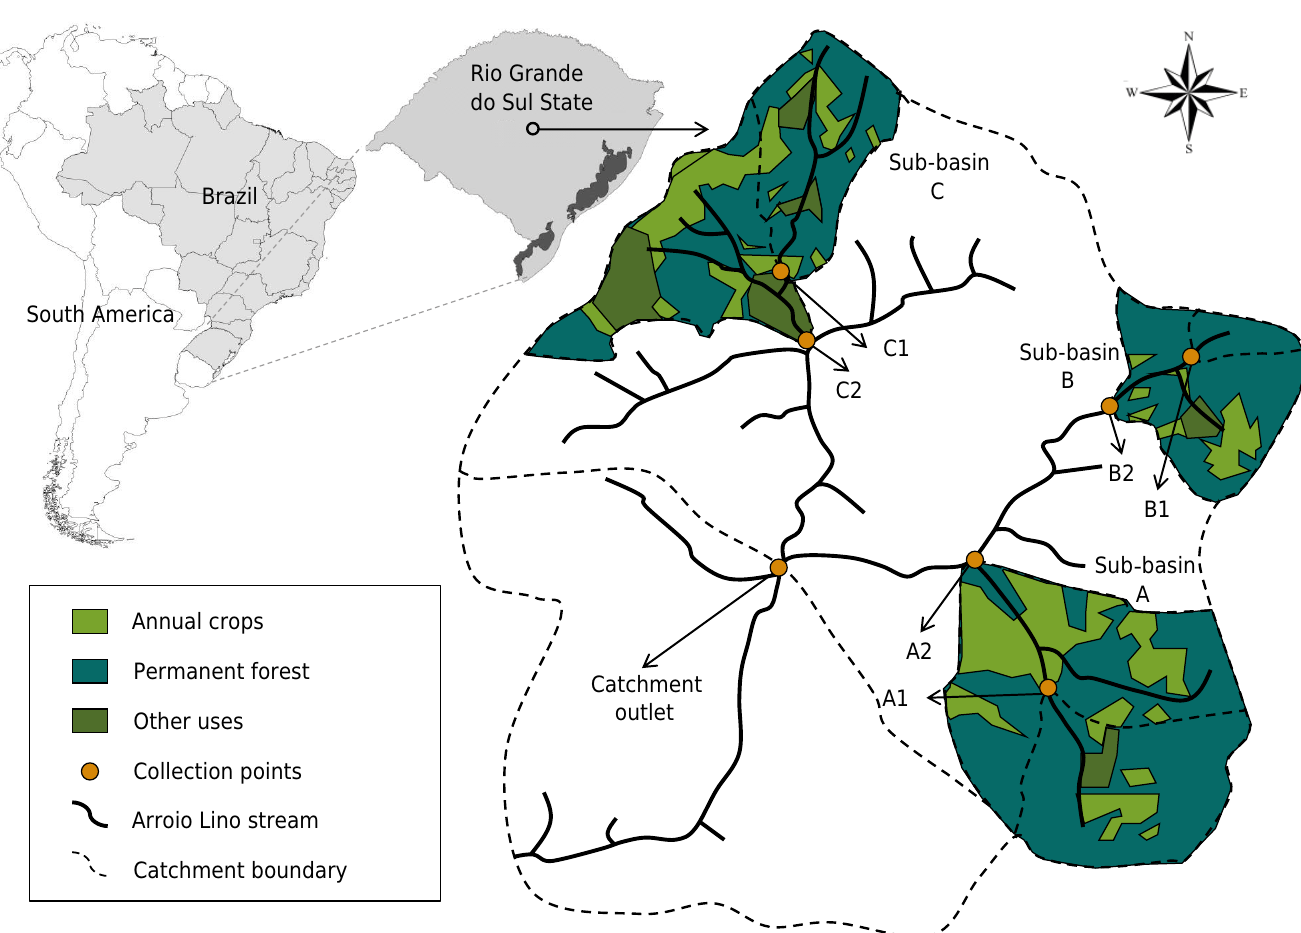
Figure 1. Arroio Lino stream, collection points of suspended sediments, catchment boundary, and land use (annual crops, permanent forest, and other uses) in the three Sub-basins (A, B, and C) monitored in Agudo catchment, Rio Grande do Sul,